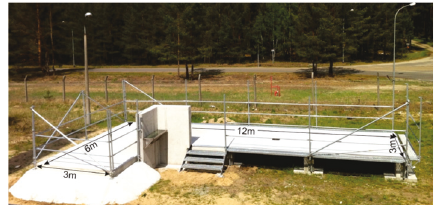
Figure 4: Large-scale test specimen of BAM,